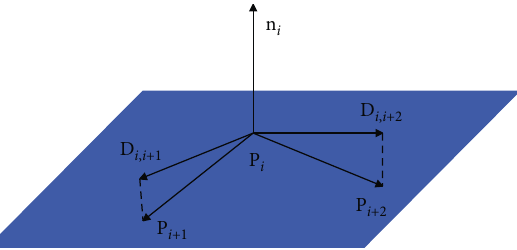
Figure 8: Estimation of the tangent vector at the vertex.